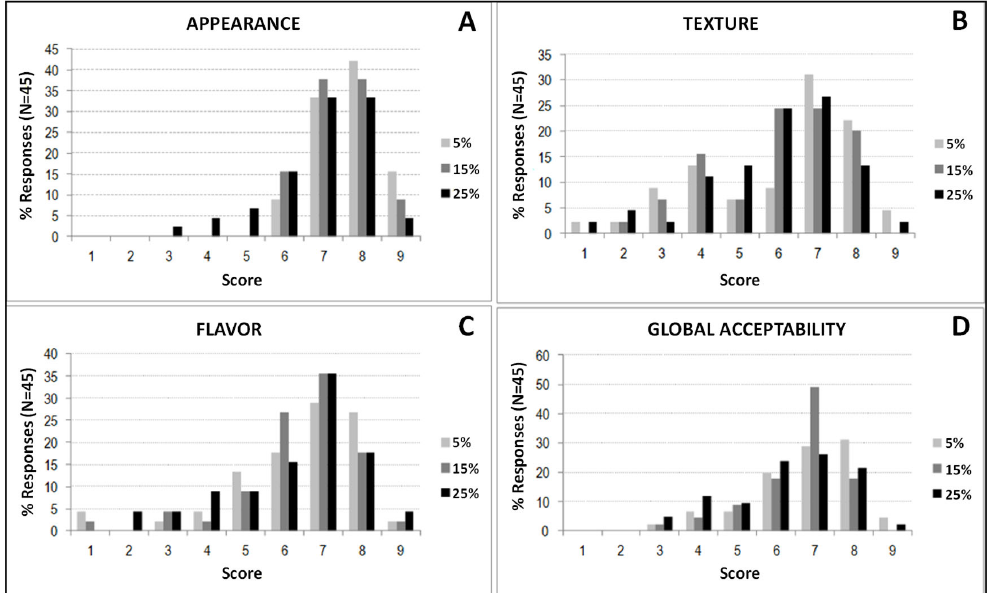
Figure 4. Percentages of responses for breads formulated with 5%, 15%, and 25% of oat flour. ( A ) Appearance. ( B ) Texture. ( C ) Flavor. ( D ) Global acceptability. Attributes: appearance, texture, flavor, overall acceptability.